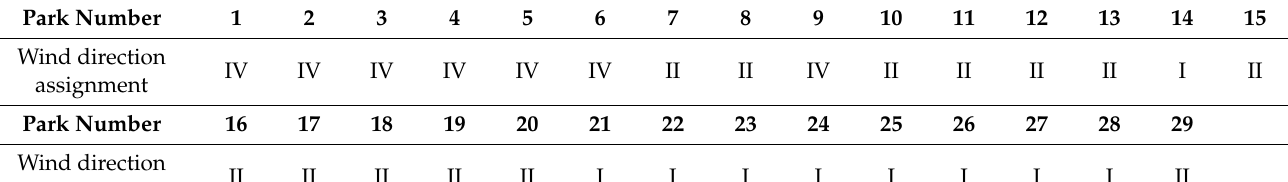
Table 12. The results of wind direction assignment of country parks.